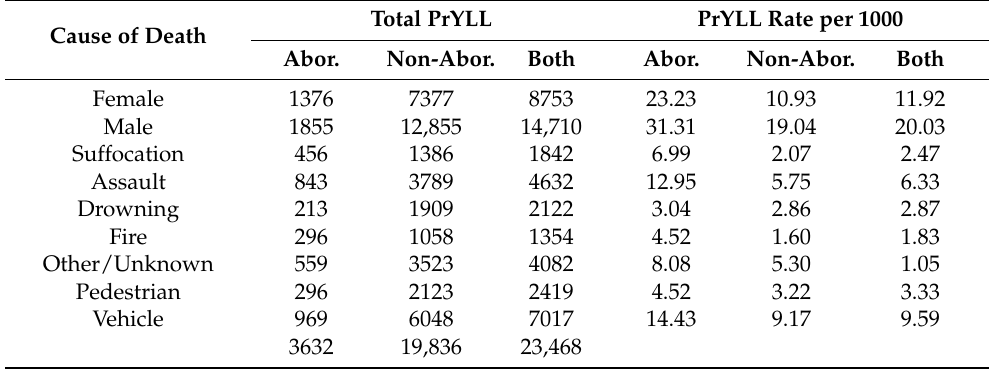
Table 4. Total Preventable Years of Life Lost (PrYLL) and the PrYLL per 1000 persons (all ages), based on an 80 year reference life expectancy, by sex, mechanism of injury, and Aboriginal status. Denominator populations are sex- and Aboriginal